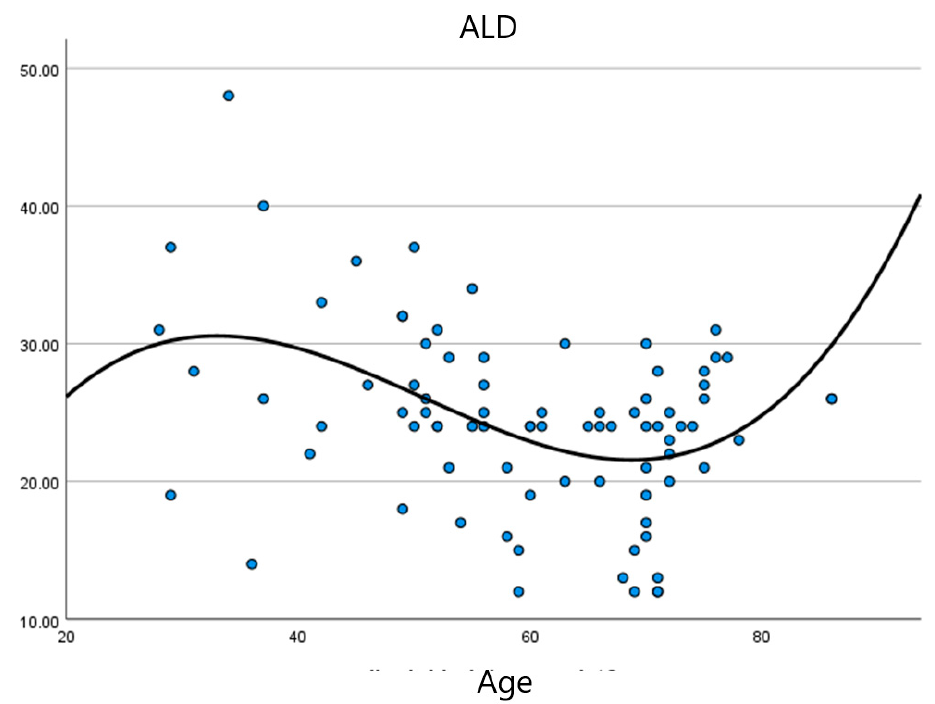
Figure 1. Relationship between ALD and age. ALD—Acceptance of living with the disease.